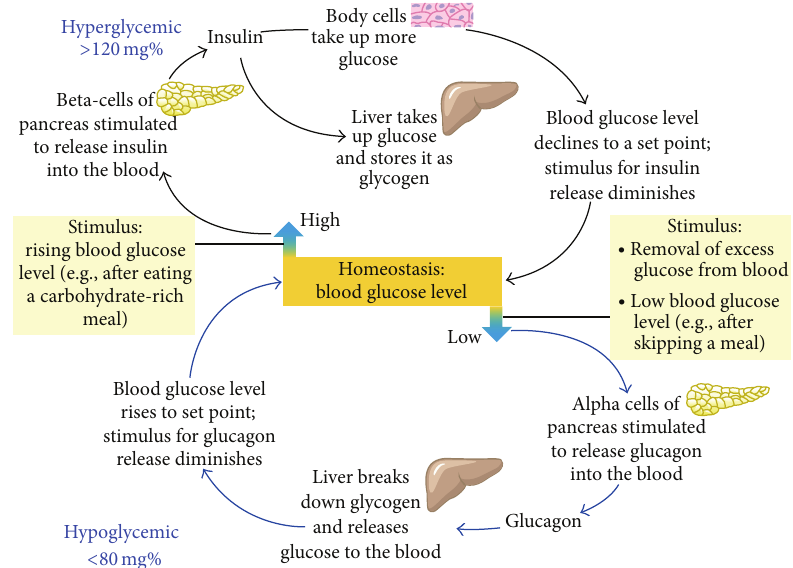
Figure 2: Glucose homeostasis in the human body (adapted from